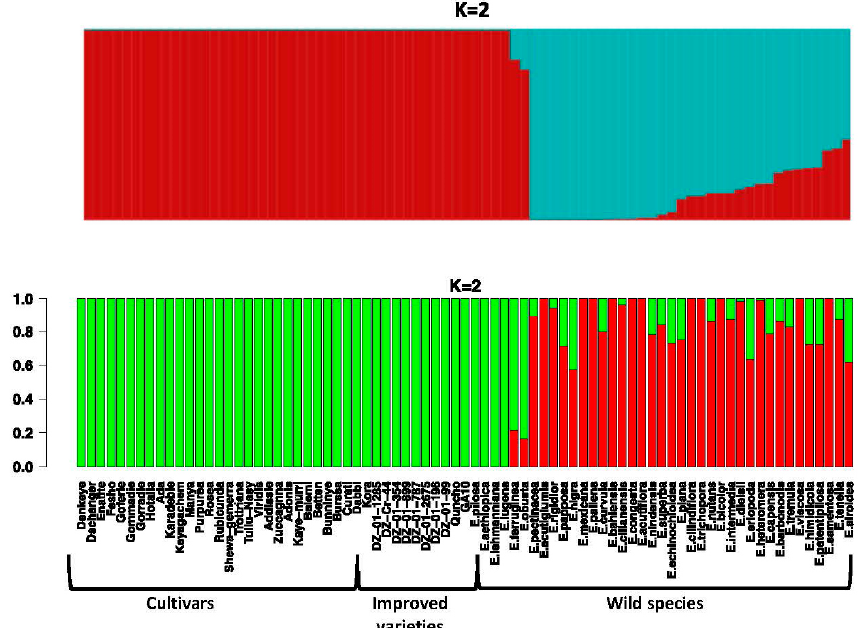
Figure 3. The population structure of Eragrostis species in the panel. ( Top ) Structure plot generated using the parameter estimates computed by the ADMIXTURE program at K = 2. ( Bottom ) Structure plot generated using the posterior mean of admixture proportions estimated by the fastStructure algorithms. Each vertical bar represents one germplasm, while each color represents the inferred ancestral population based on K clusters (in this case K = 2). For each germplasm, columns fully colored with only one color represent genetic homogeneity, while columns with mixed colors illustrate admixture.